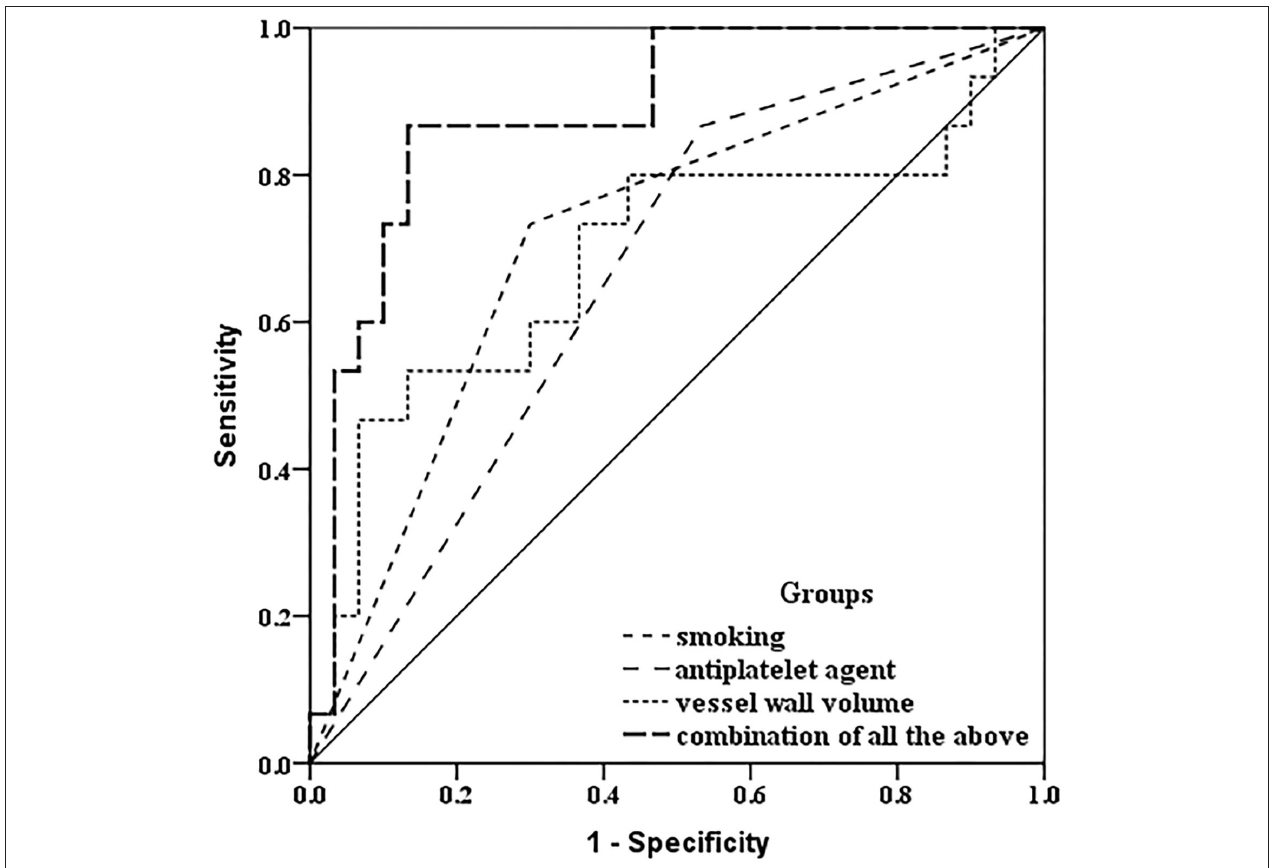
FIGURE 4 | Receiver operating characteristic comparison analysis. In discriminating the progressed IPH group, receiver operator curve analysis indicated that combined with a baseline history of current or past smoking, taking an antiplatelet agent at baseline, and larger baseline carotid plaque-containing vessel wall volume, there was incremental improvement in the area under the curve (AUC: 0.887) compared with a baseline history of current or past smoking only (AUC: 0.717), taking an antiplatelet agent at baseline only (AUC: 0.667), and larger baseline carotid plaque-containing vessel wall volume (AUC: 0.691)